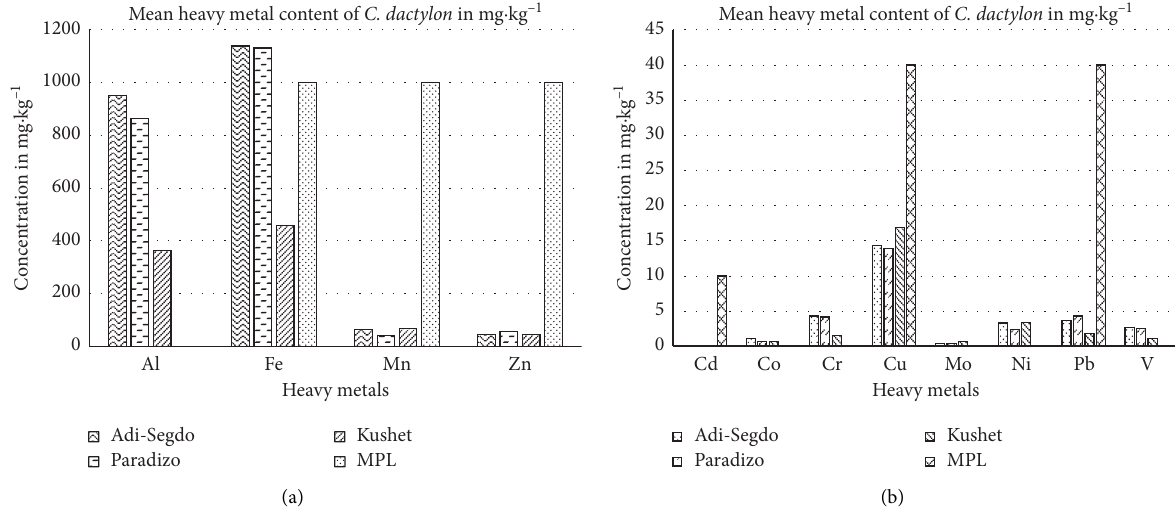
Figure 4: (a) Mean heavy metal content of C . dactylon from the three sites. (b) Mean heavy metal content of C . dactylon from the three sites.